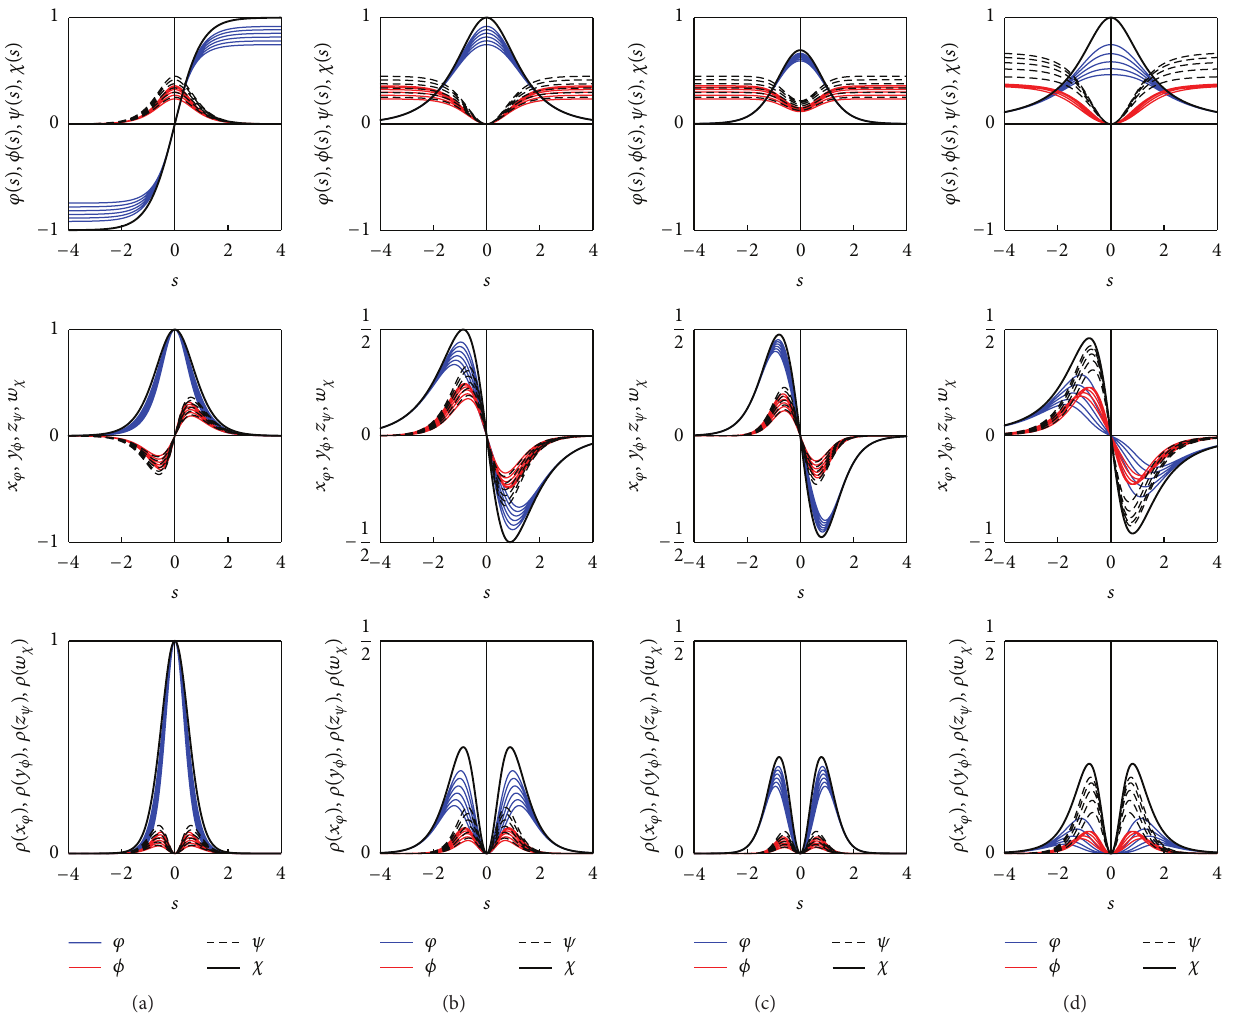
Figure 6: The 4 -cyclica deformed defects obtained from hyperbolic deformation functions. Results from each column are for four different triggering solutions for 𝜒(𝑠) , in respective correspondence with (85)–(88). In the first column results are for the primitive 𝜆𝜒 4 kink solution, 𝜒(𝑠) (thick black line), which triggers the 4 -cyclic chain with the kink-like deformed defects, 𝜑 (𝑛) (𝑠) (blue lines), a first family of lump-like deformed defects, 𝜙 (𝑛) (𝑠) (red lines), and a second family of lump-like deformed defects 𝜙 (𝑛) (𝑠) (thin black lines). We have set 𝑛 = 𝑘𝜋/6 with 𝑘 in the range between 1 and 2 , by steps of 0.2 units, in order to qualitatively depict the analytical profile related to 𝑛 . Second, third and forth columns are merely